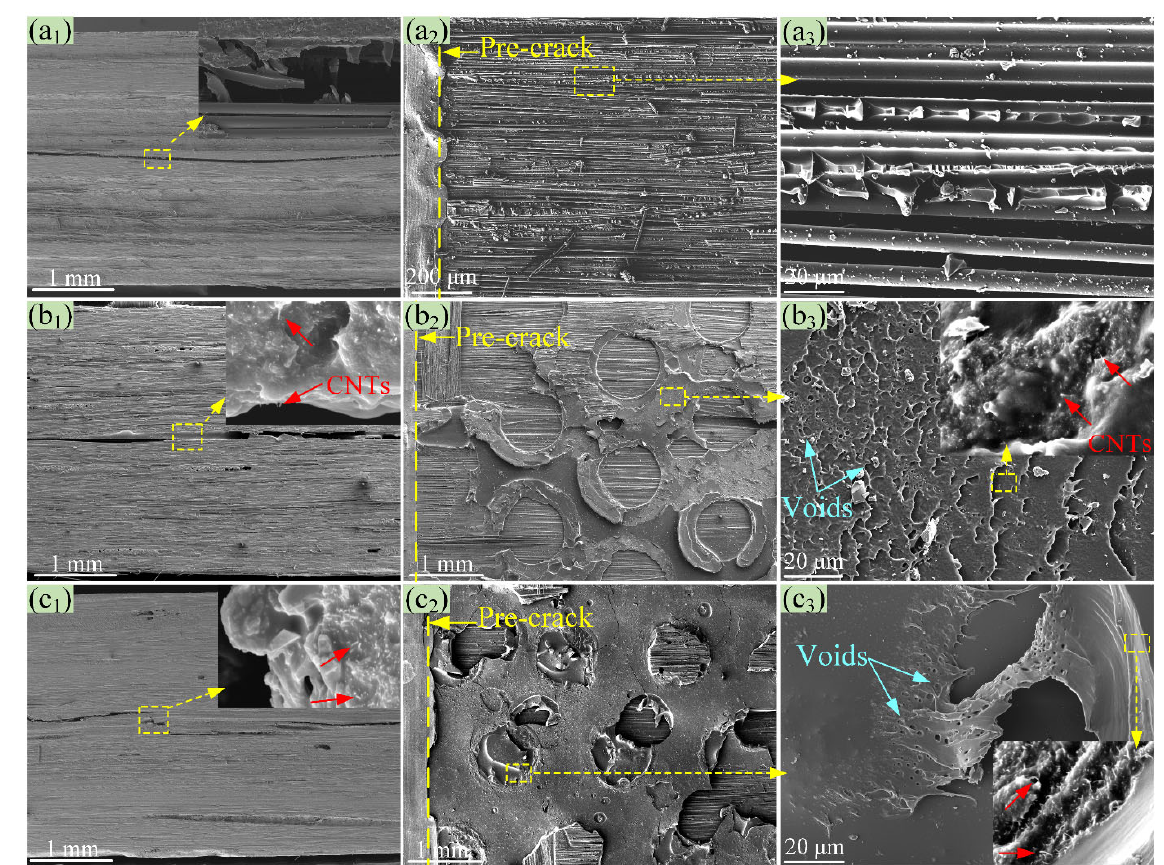
Figure 8. SEM images of the fractured ENF specimens, ( a 1 – a 3 ) baseline CFRP, ( b 1 – b 3 ) CNT/EP ‐ EMAA ‐ CNT/EP CFRP, ( c 1 – c 3 ) EMAA ‐ CNT/EP ‐ EMAA CFRP.